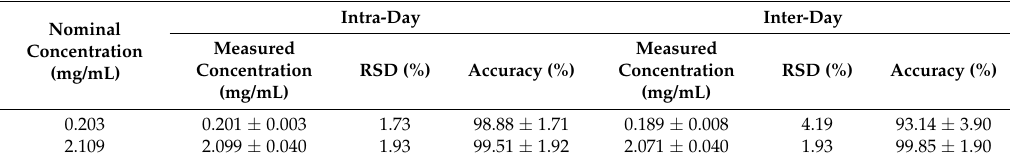
Table 2. Intra-day/inter-day accuracy and precision of EGCG in water.